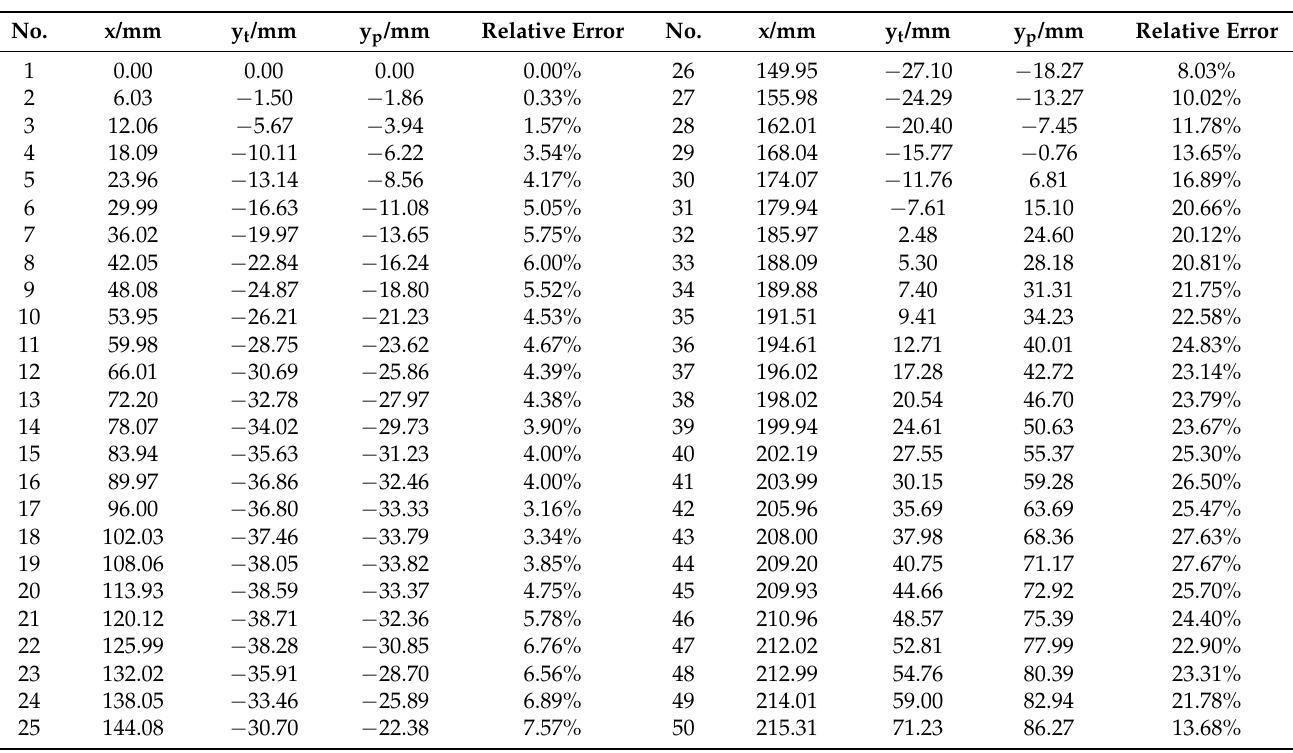
Table 8. Real value, predicted value, and relative error of coordinates of each point on the middle line of fruit-bearing